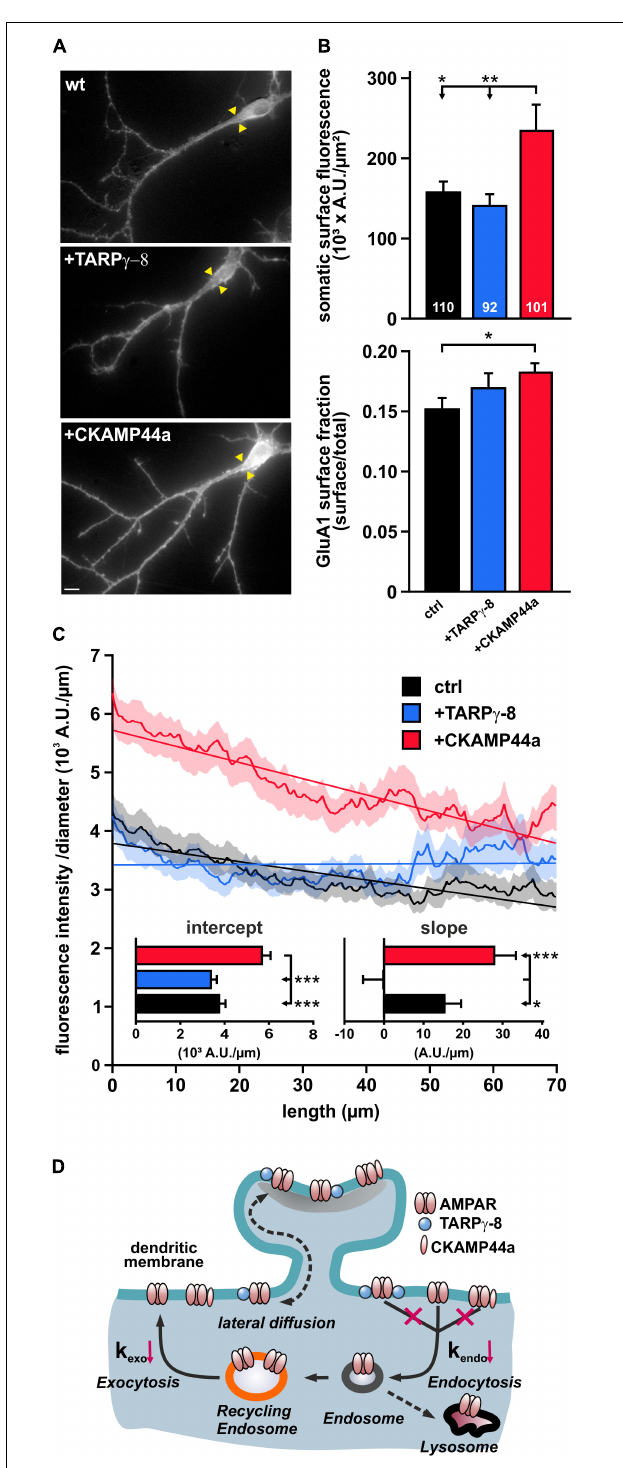
FIGURE 6 | Overexpression of auxiliary subunits differently affects AMPARs surface distribution. (A) Exemplary difference images show the “isolated” surface SEP-GluA1 signal in control neurons and cells overexpressing either TARP γ -8 or CKAMP44a (scale bar = 10 µ m). Yellow arrowheads mark the assumed origin of the neurite, which was used as the starting point for the